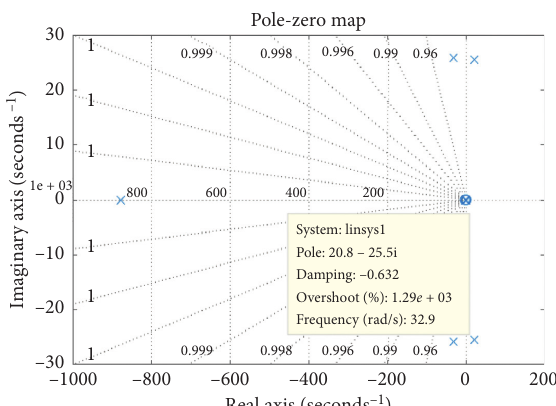
Figure 5: Closed loop pole distribution without the controller in Section 3.3.